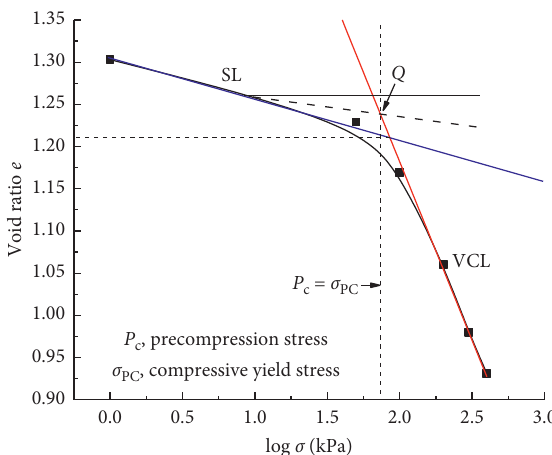
Figure 6: Calculation of compressive yield stress σ section method.